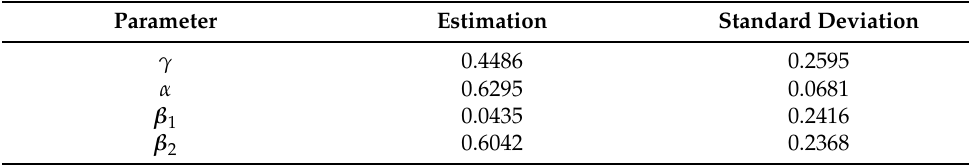
Table 6. Estimation